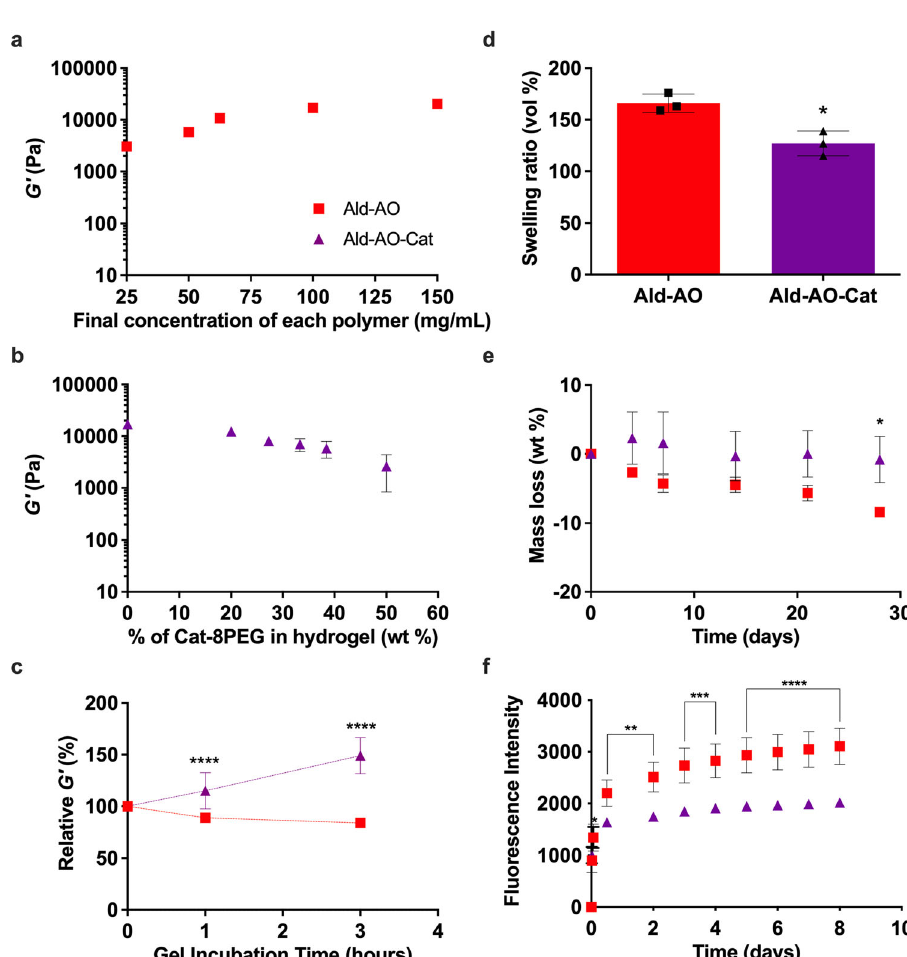
Fig. 2 Characterization of rapidly gelling oxime hydrogels. a Storage moduli ( G ′ ) were measured as a function of fi nal polymer mass concentration in Ald – AO gels using a frequency sweep from 10 − 2 to 10 2 Hz at 37°C; G ′ at 1Hz is shown. b Ald – AO – Cat gels with varying Cat-8PEG content were gelled and G ′ was measured under the same conditions. Increasing Cat-8PEG content of the gels resulted in decreasing G ′ . c G ′ for Ald – AO – Cat and Ald – AO